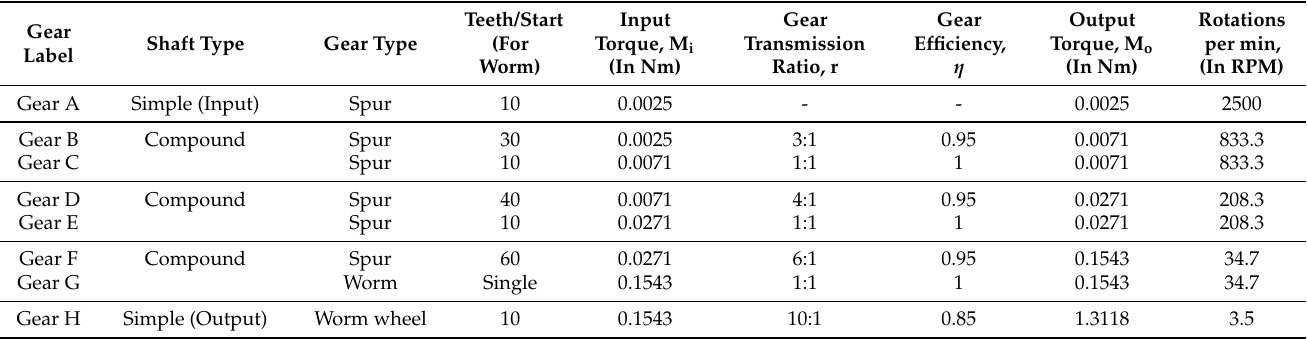
Table 1. Transmission gear train